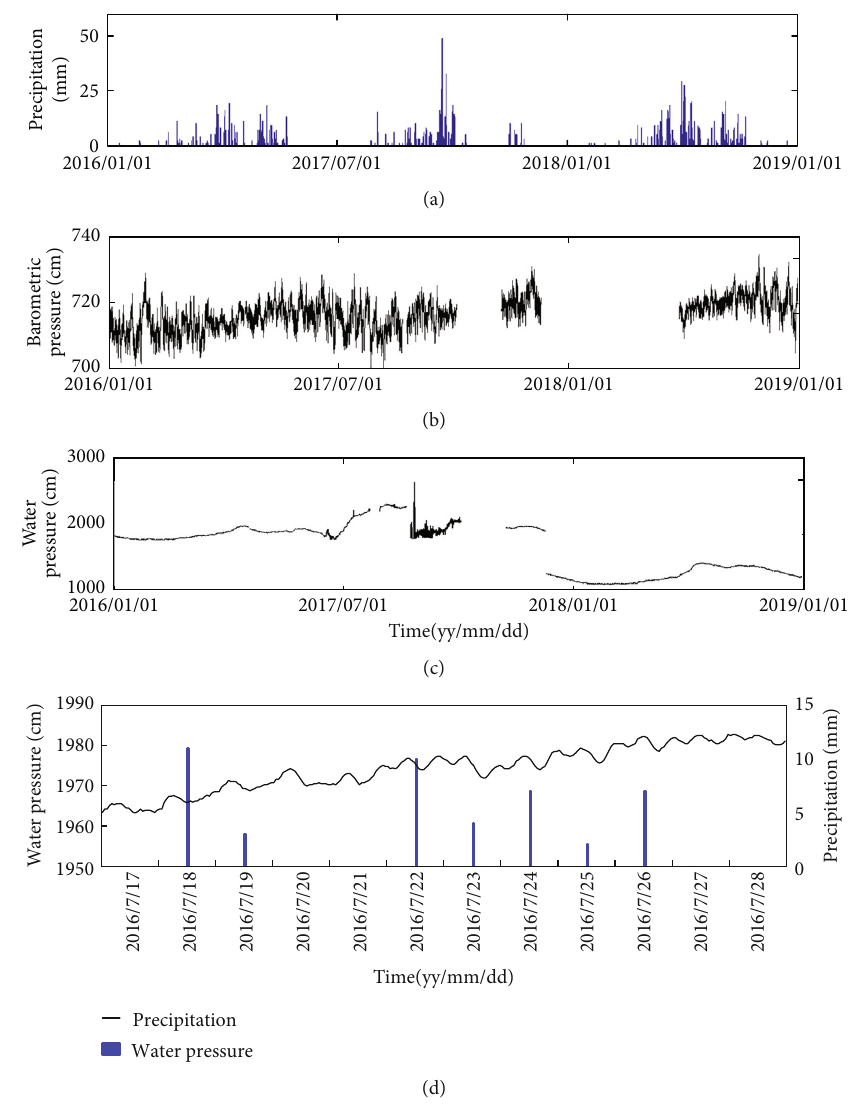
Figure 3: (a) Daily precipitation, (b) hourly barometric pressure, (c) hourly ground-water levels of ZK01, and (d) enlarged view of water pressure showing that water pressure recorded by the Diver logger are not a ff ected by local